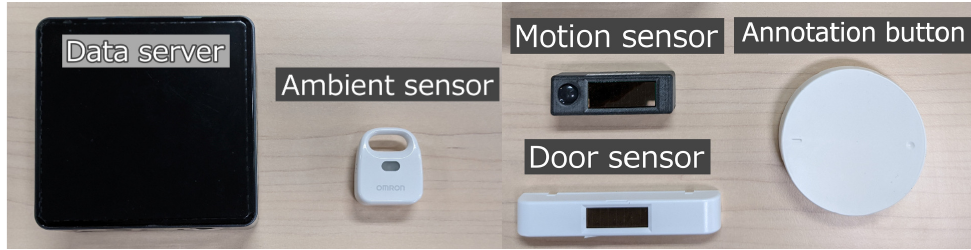
Figure 3. Components of the SALON